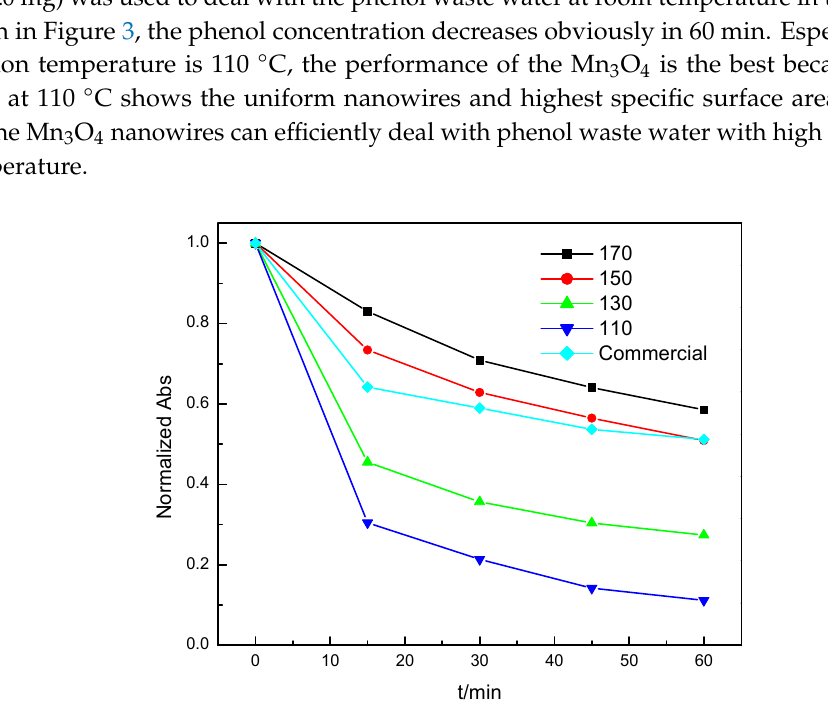
Figure 3. Effect of preparation temperature on the performance of Mn 3 O 4 (From top to bottom: 170; 150; 130; 110 °C and commercial Mn 3 O 4 ).